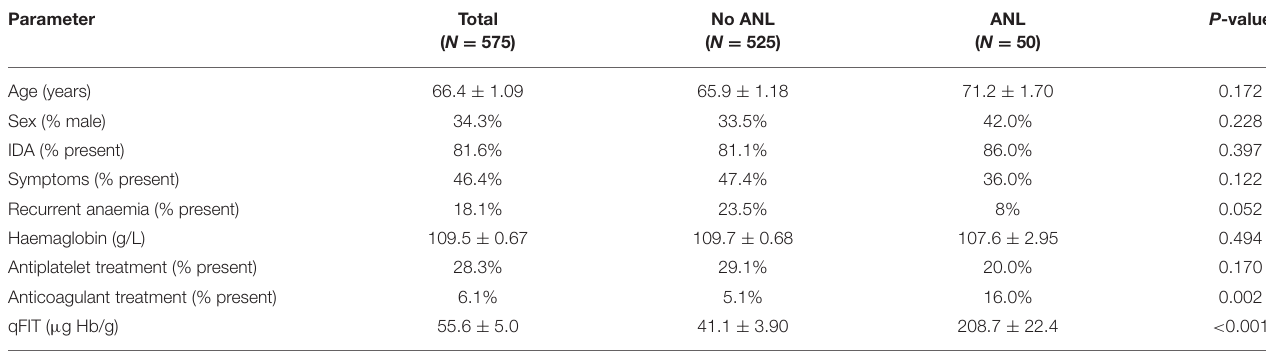
TABLE 1 | Demographic and clinical parameters.